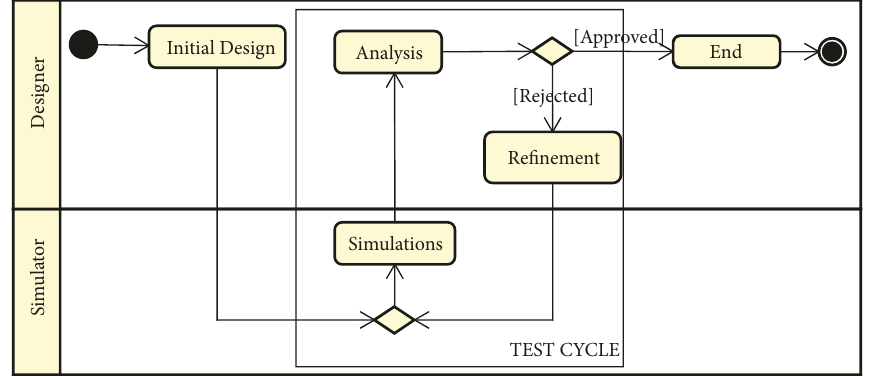
Figure 2: Actions of game